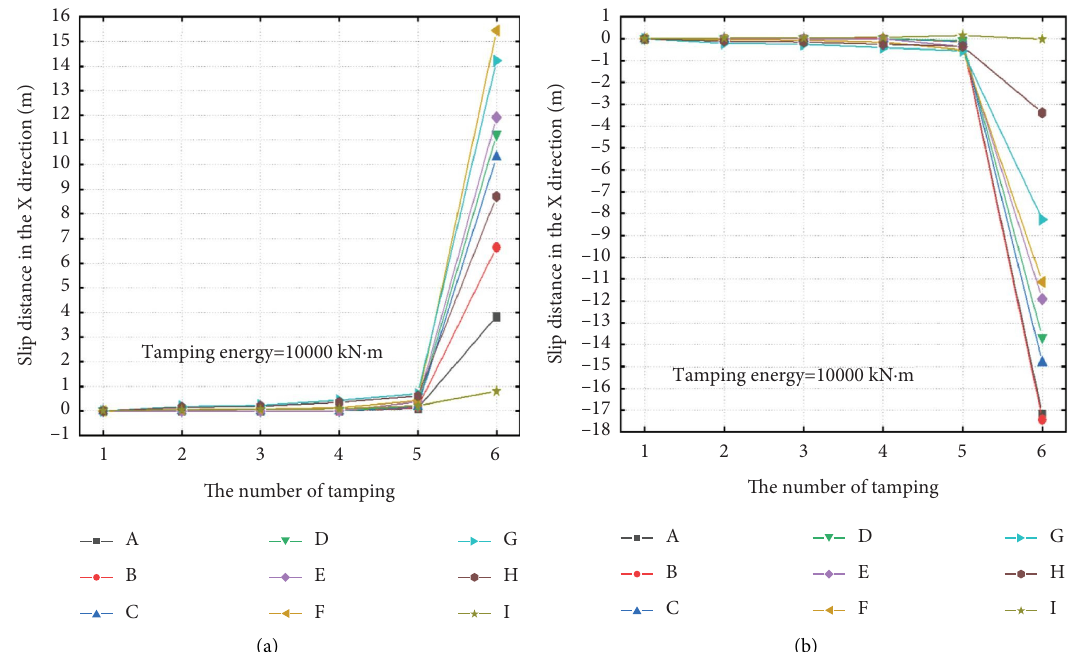
Figure 11: Horizontal and vertical displacements of soil at diferent positions under the action of 10000kN · m. (a) Horizontal displacement and (b) vertical displacement.